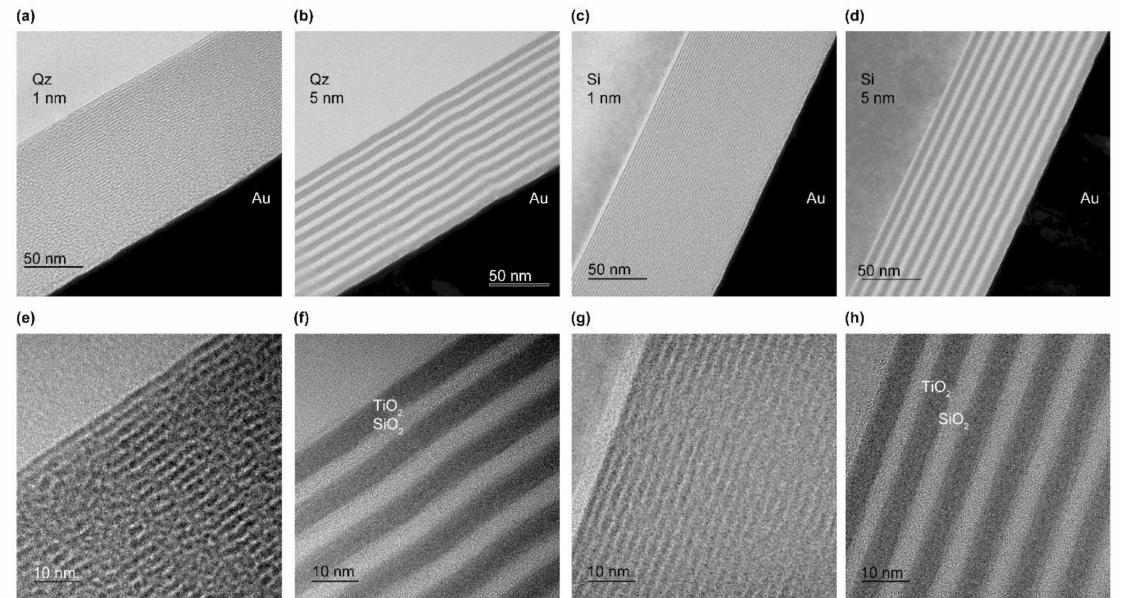
Figure 3. TEM images of the TiO 2 /SiO 2 multilayered samples. Samples on quartz glass (Qz) of ( a , e ) 1 nm and ( b , f ) 5 nm for each layer and on Si of ( c , g ) 1 nm and ( d , h ) 5 nm for each layer. The total thickness of all samples was 100 nm. The scale bar is 50 nm and 10 nm for upper and bottom, respectively.